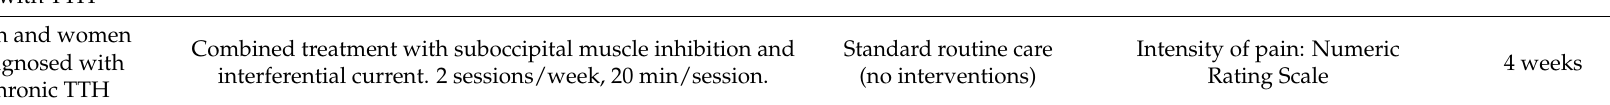
Occiput-atlas-axis manipulation (OAA) and soft tissue massage.1 session/week. 4 weeks TG1: Soft tissues techniques.1 session/week.4 weeks TG2: Neural mobilization techniques 1 session/week.4 weeks TG3: Combined treatment involving soft tissue and neural mobilization techniques 1 session/week. 4